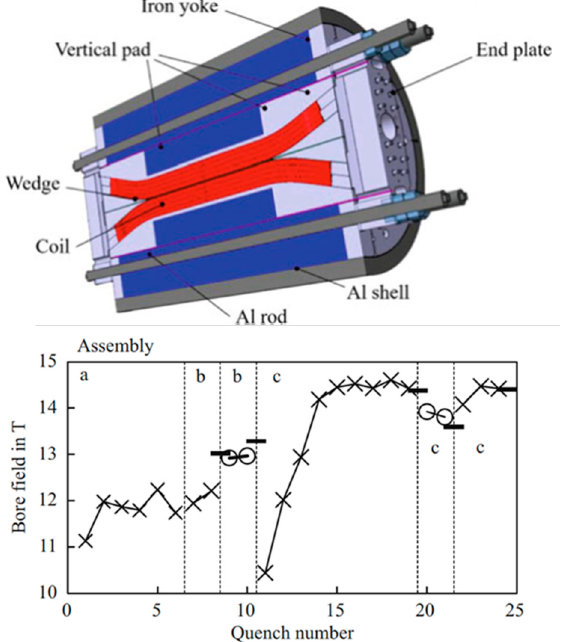
Figure 2. 3D sketch and training curve of the Fresca2 dipole. The letters a, b, and c in the quench plot refer to various assemblies and different prestress configurations.